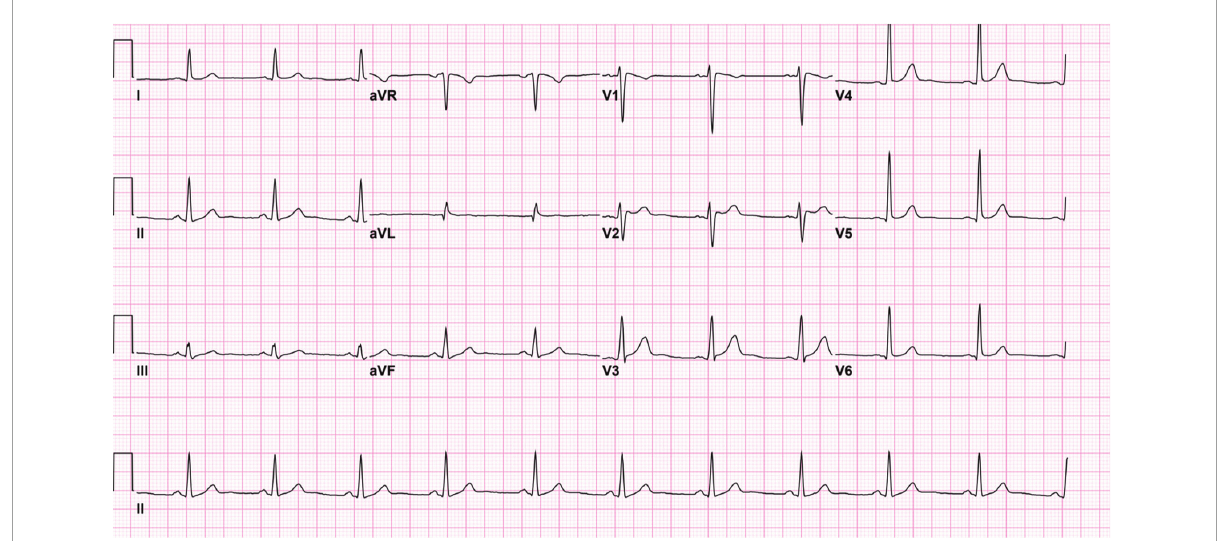
FIGURE3 Twelve-lead electrocardiogram after the discontinuation of lamotrigine. The electrocardiogram demonstrates normal sinus rhythm with near resolution of the J-point elevation and type 1 Brugada pattern.